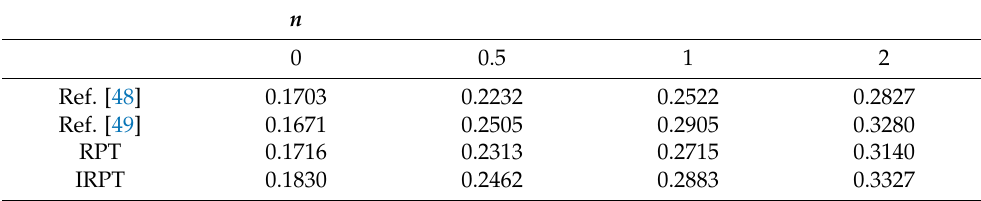
Table 2. Dimensionless central deflection values of Al/ ( ZrO 2 ) -1 functionally graded square plates under a transverse uniform load. ( R = S = 10, N L = 10, a / h =